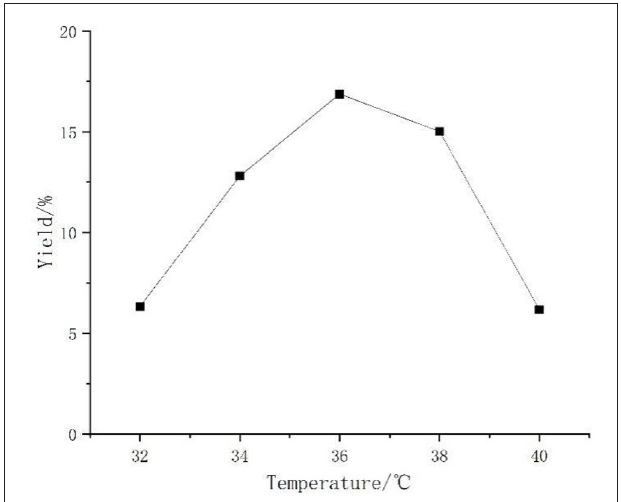
FIGURE 2 | Effect of temperature on the yield of Artemisia polysaccharides.